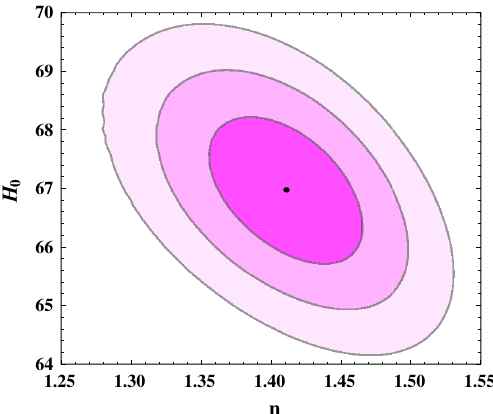
Fig. 10 Figure shows the likelihood contour in the n – H 0 plane for H ( z ) data set. The dark shaded region shows the 1 σ error, light shaded region shows the 2 σ error and the ultralight shaded region shows the 3 σ error. A black dot represents the best fit value of the model parameter n and the values of H 0 in the plot. Here, H 0 is in units of km/s/Mpc